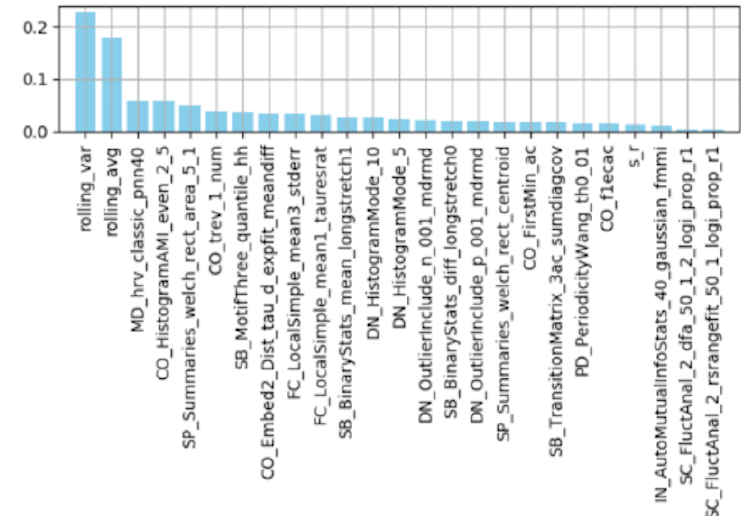
Figure 3. HAD feature importance for Random Forest on Huawei dataset.